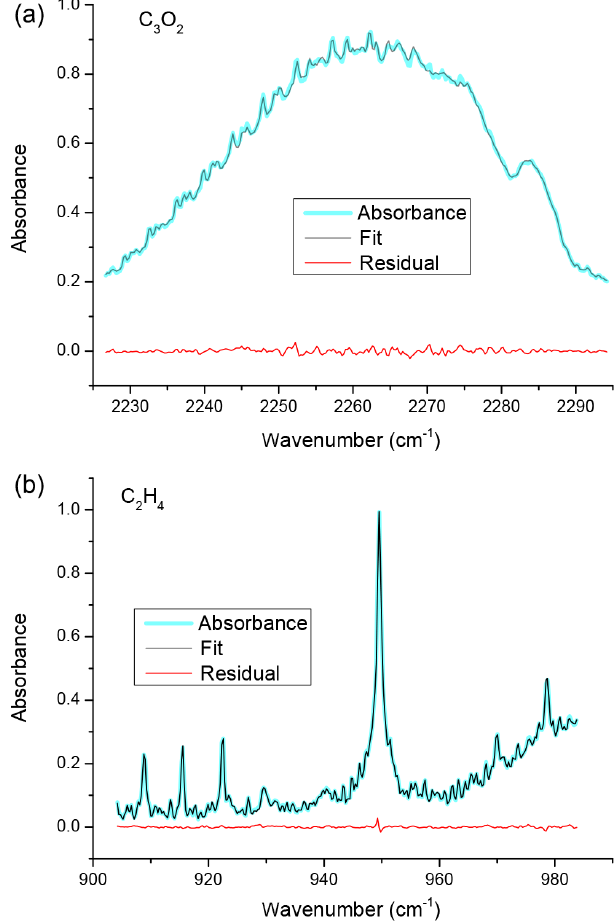
Figure 5. Examples of least-squares fitting to reference spectra (be- fore the reaction was initiated) to obtain the depletion factors for C 3 O 2 (upper panel) and C 2 H 4 (lower panel) in the relative-rate ex- periments. The red lines show the